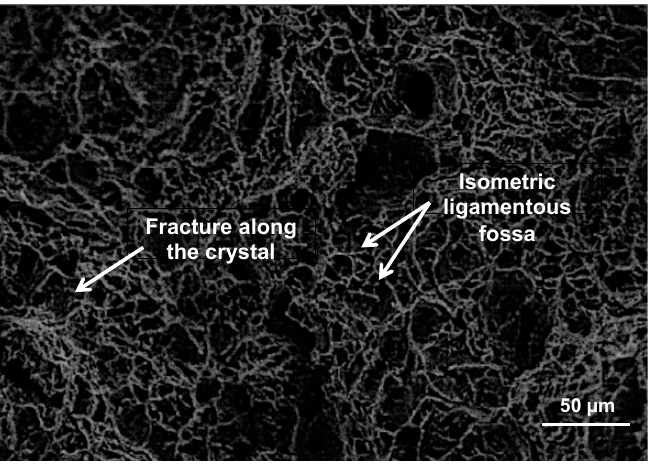
Figure 6. Fracture analysis of 12Cr1MoV steel at 60,000 h.